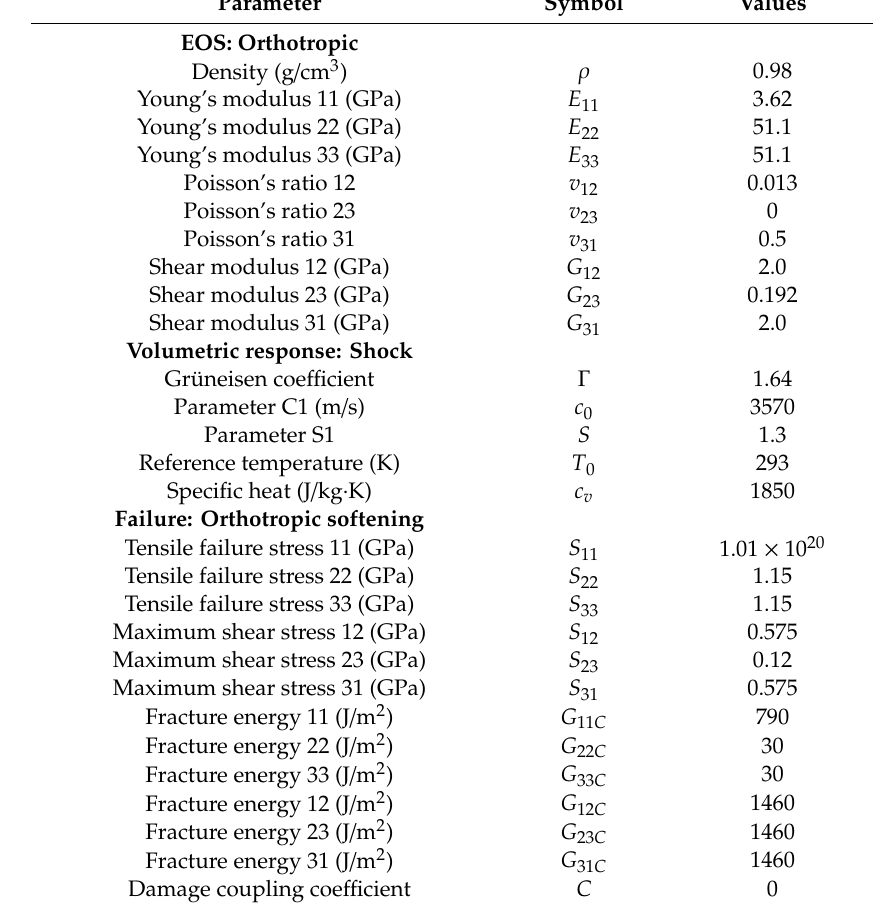
Table 4. The parameters for UHMW-PE used in non-linear orthotropic material model